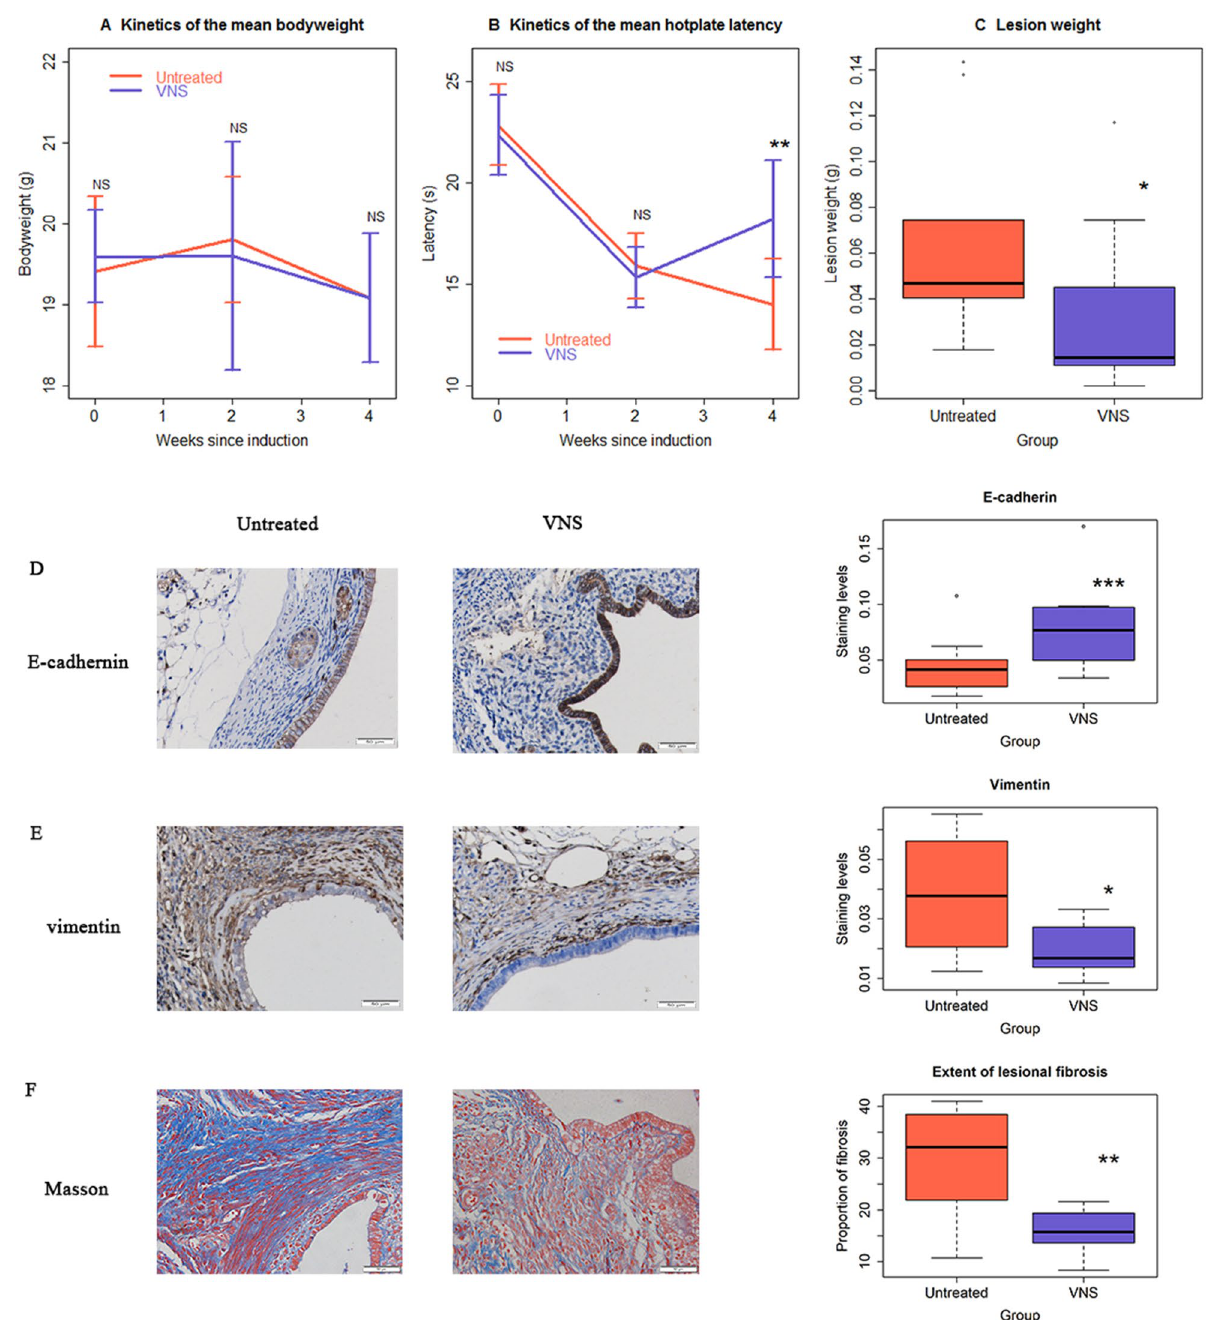
Figure 4. Vagal nerve stimulation (VNS) demonstrates its therapeutic potentials in mouse with well-established endometriosis. ( A ) Kinetics of the mean bodyweight in VNS and the untreated groups. No significance was found between the two groups at any time point evaluated. ( B ) Kinetics of the mean hotplate latency, tested at the indicated time points, in the two groups. Statistically significant difference in latency between the two groups is found 2 weeks after the treatment with VNS. ( C ) Boxplot summarizing the lesion weight in the control and VNS groups. Representative immunostaining results for E-cadherin ( D ) and vimentin ( E ) in endometriotic lesions from untreated and VNS-treated mice (left panel), along the boxplot summarizing the staining data (right panel). ( F ) Representative images of Masson trichrome staining in endometriotic lesions in the two groups (left panel), along with the boxplot summarizing the staining data (right panel). The smooth muscle cells are stained in red and collagen fibers in blue. n = 10 in each group. The asterisk indicates the statistical significance level, which was calculated based on multiple linear regression analyses: NS: p > 0.05; * p < 0.05; ** p < 0.01; *** p < 0.001. In all regressions, R 2 ≧